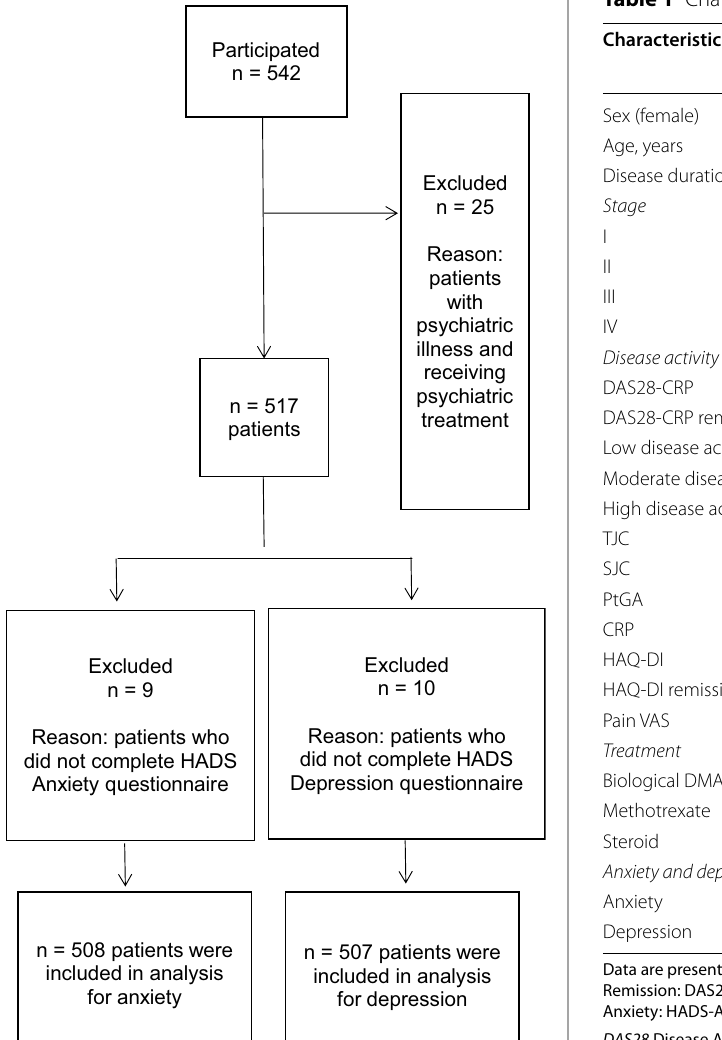
Table 1 Characteristics of patients with rheumatoid